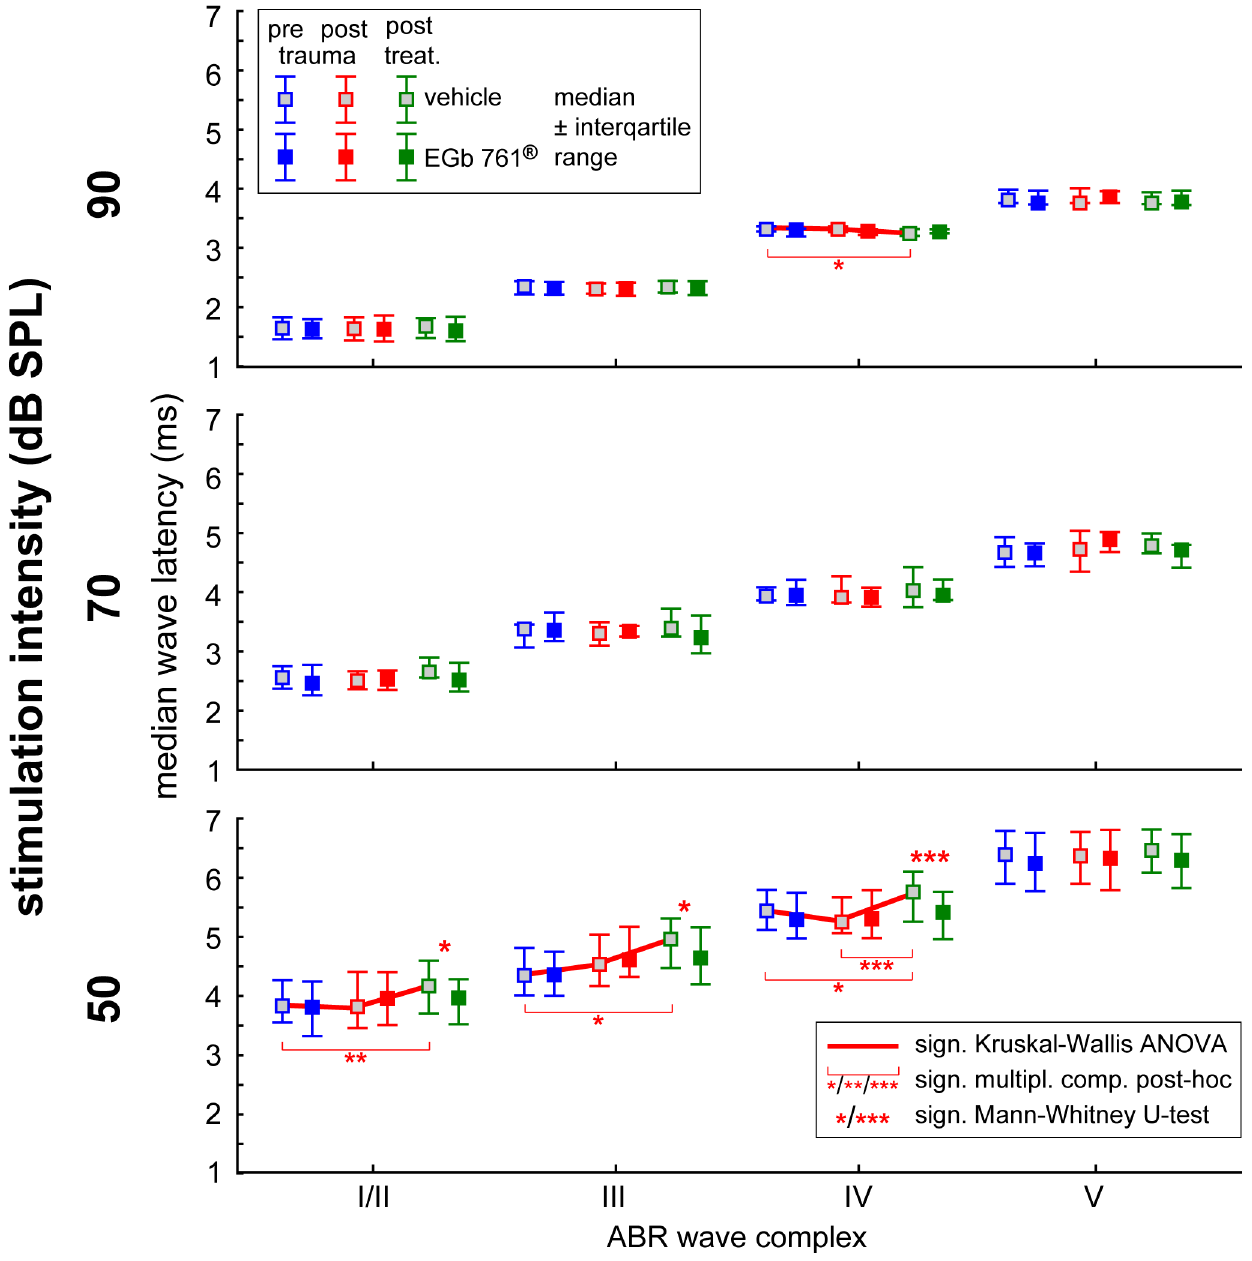
Fig 6. EGb 761 alters median ABR wave latencies. Median latencies ( ± interquartile interval) are given for three different stimulus intensities (90, 70, 50 dB SPL) and three different time points (before trauma, immediately after trauma, and after treatment). Red lines indicate significant Kruskal-Wallis ANOVAs over the three time points within one group and wave data, Asterisks indicate levels of significance in Mann-Whitney U-tests between the groups at one time point. * p < 0.05, *** p < 0.001.